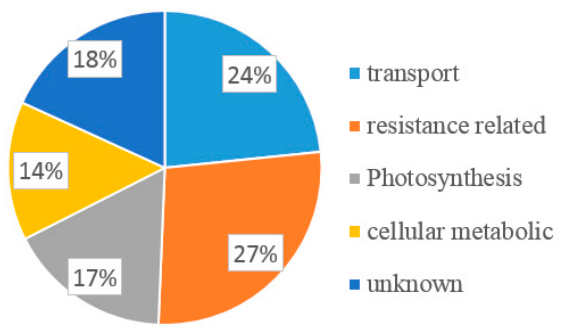
Figure 2. Function classification of all the potential candidate interactors of P3 by their putative function blasted in plant.